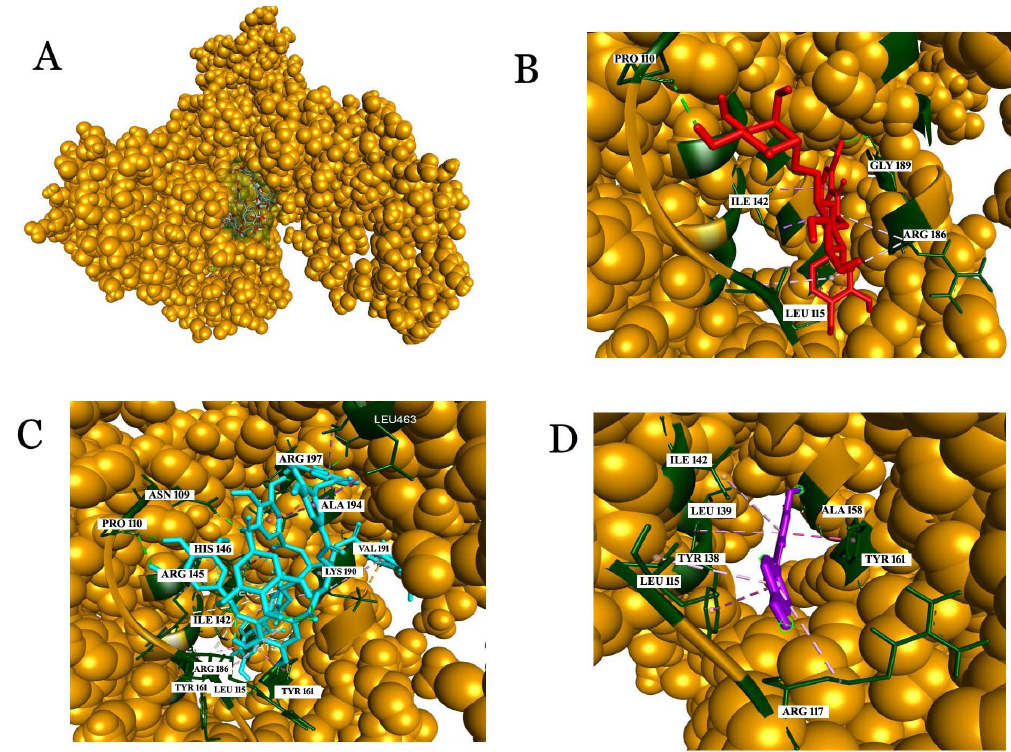
Figure 6. Analysis of interactions with human serum albumin (HSA). ( A ) The green-colored surface represents the binding pocket of the HSA protein (CPK model). ( B ) Interaction of rutin with the amino acids in the binding pocket, ( C ) tannic acid, and ( D )